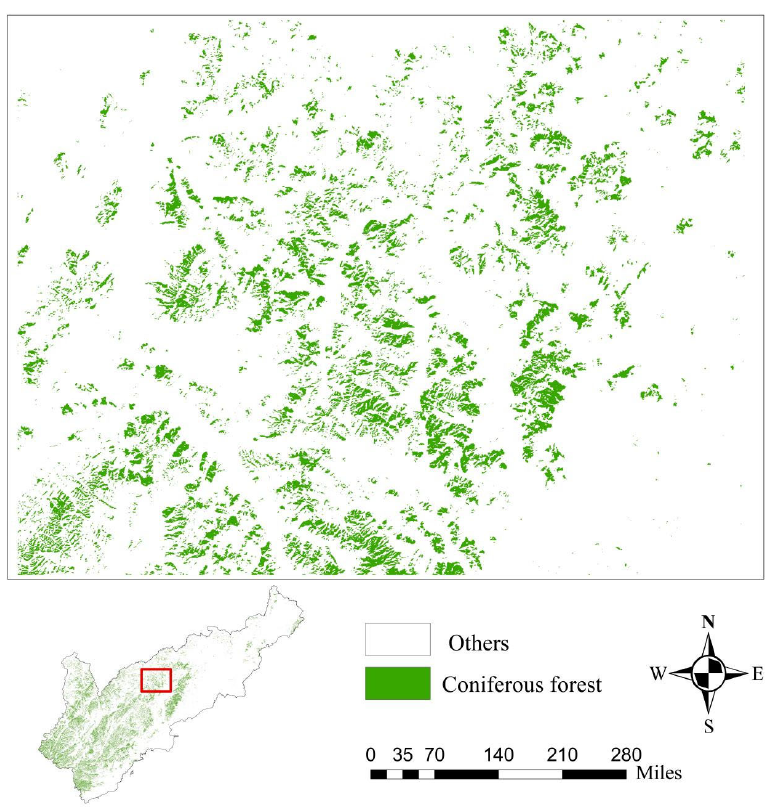
Figure 17. The distribution of the coniferous forests in Northwestern Liaoning in the year 2020.